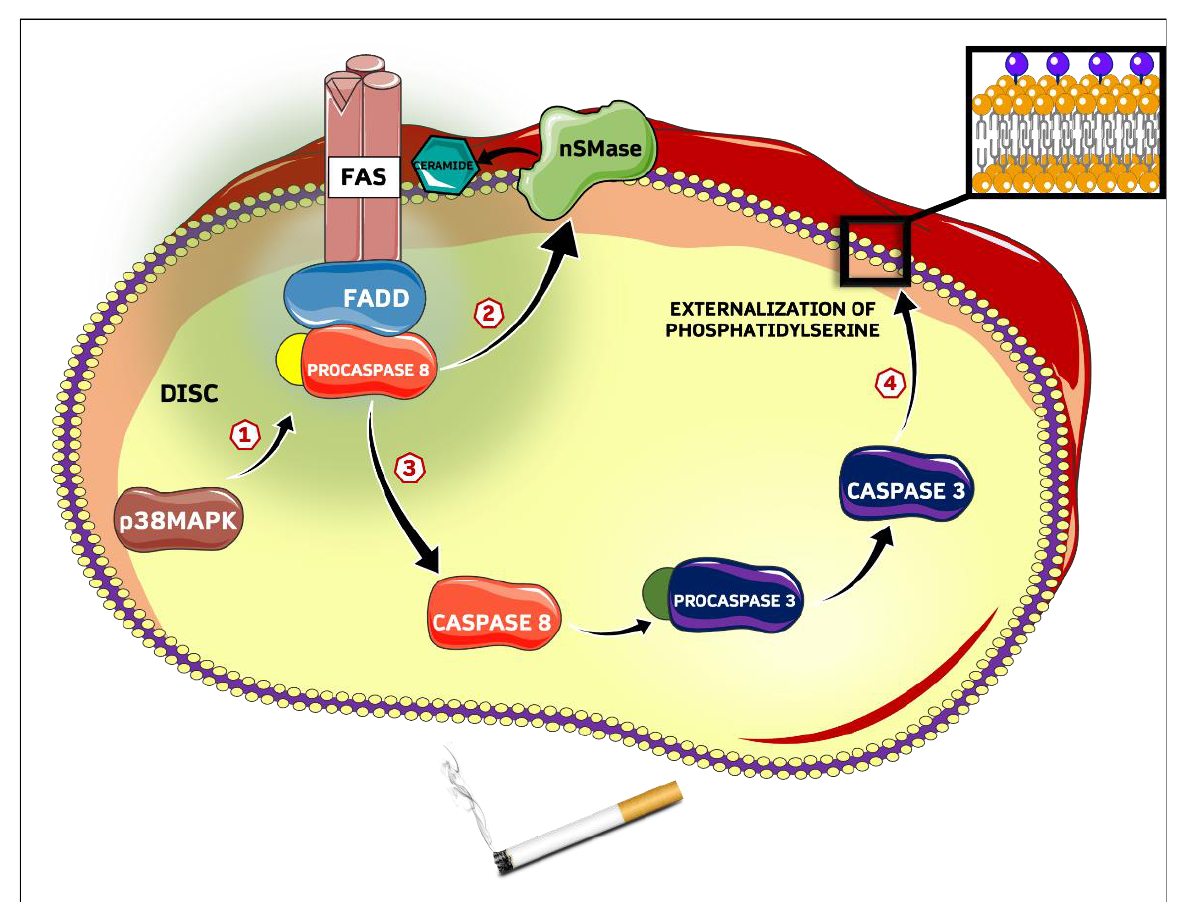
Figure 7. Proposed mechanism for CSE-induced eryptosis. 1: Phosphorylation of p38 MAPK acti- vates DISC assembly with activation of caspase-8; 2: Ceramide production by nSMase is regulated by procaspase-8; 3: Trimerization of Fas and binding with FADD and procaspase-8 is followed by the caspase activation cascade; 4: Active subunit of caspase-3 causes loss of asymmetry of membrane phospholipids with final phosphatidylserine externalization.